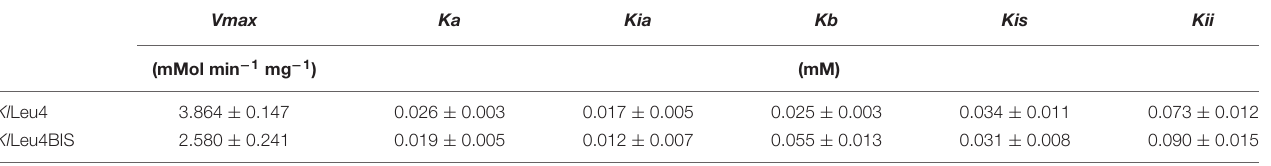
TABLE 2 | Kl Leu4 and Kl Leu4BIS fitted kinetic